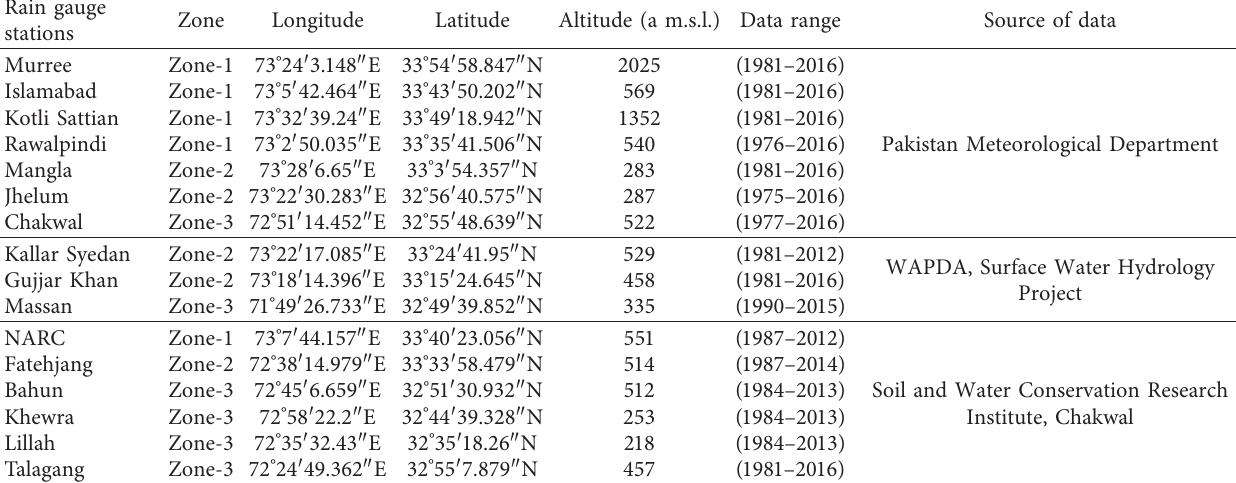
Table 2: Description of the meteorological